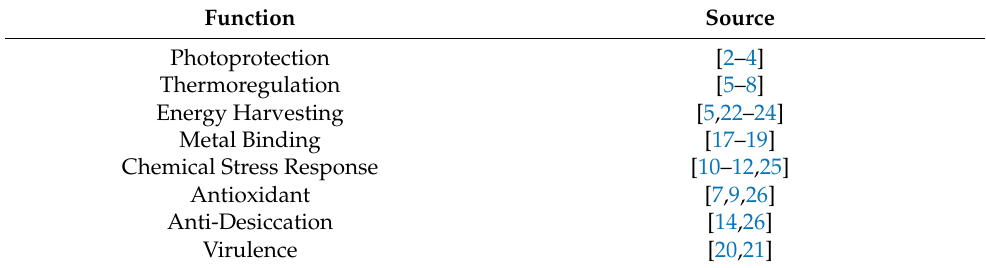
Figure 1. Panel of four images of different melanized fungi. Xylaria polymorpha (top left), a mushroom also referred to as ‘Dead Man’s Fingers.’ The stromata of X. polymorpha have an average total length, including rooting bases, of 5 to 8 cm by an average 2 cm diameter [27]. “Black fungi— Xylaria polymorpha (dead man’s fingers)” by ohi007 is licensed under CC BY-NC-SA 2.0; Cladophialosphora bantiana (top right), a pathogenic mold. C. bantiana conidia are approximately 5 to 10 µ m in length [28]. “File:Cladophialophora bantiana UAMH10767.jpg” by Medmyco is licensed under CC BY-SA 4.0; Inonotus obliquus (bottom left), also known as the Chaga mushroom. Chaga appears as a sclerotia ranging from 5 to 40 cm in diameter [29]. “Chaga mushroom ( Inonotus obliquus )” by Distant Hill Gardens is licensed under CC BY-NC-SA 2.0; Cryptococcus neoformans (bottom right), a pathogenic yeast. Cryptococcal cells range from 5 to 10 µ m in diameter [30]. “Cryptococcosis—GMS stain” by Pulmonary Pathology is licensed under CC BY-SA 2.0. Images presented are not to scale. Table 1. Examples of the functions of fungal melanin in living fungal